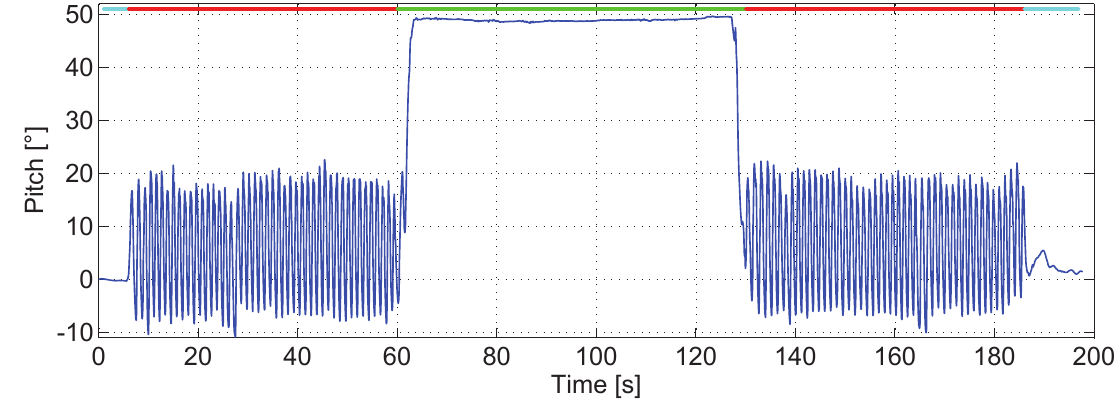
Figure 6. Pitch angle estimation of a walk, including standing, walking and